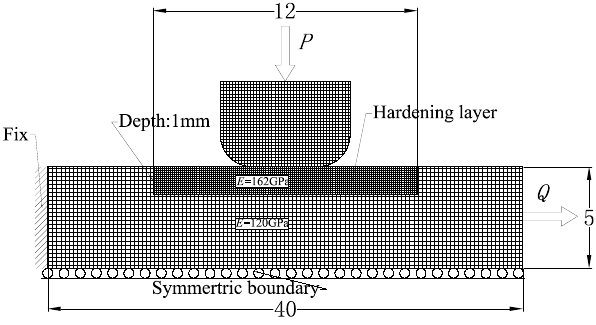
Figure 12. Schematic diagram of the finite element model.